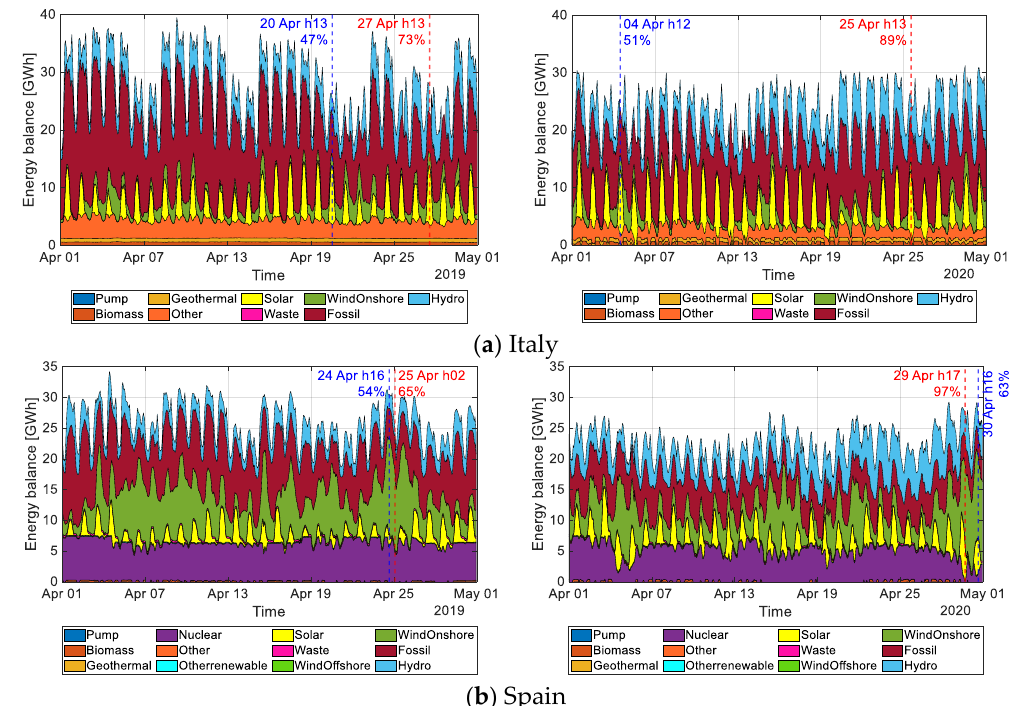
Figure 6. Load coverage by source for two selected countries.